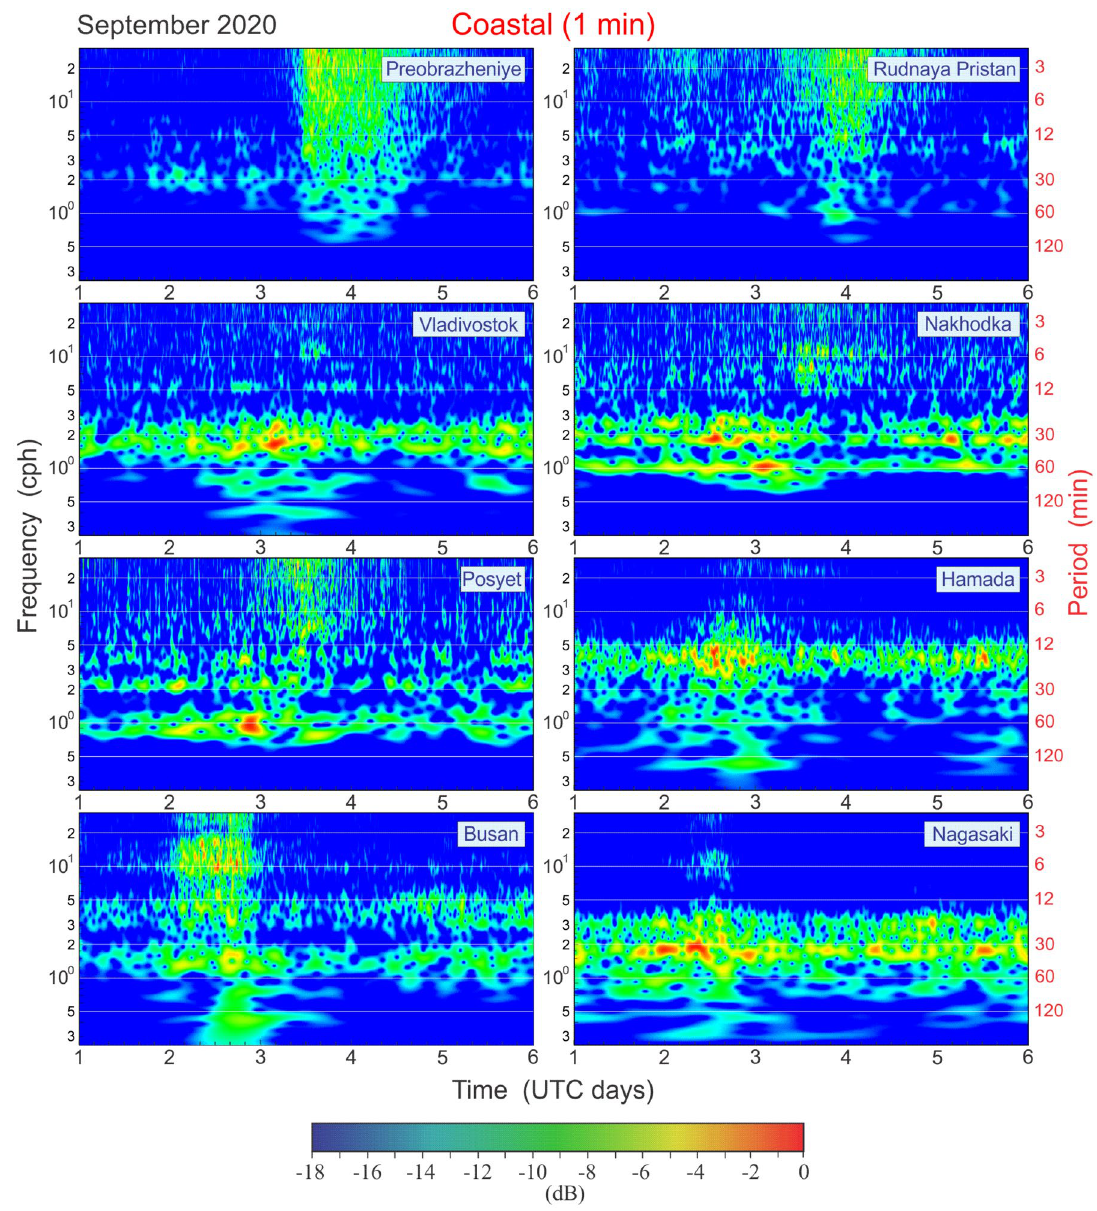
Figure 4. Frequency–time plots ( f–t diagrams) for the 1–6 September 2020 residual and high-pass filtered sea level records during the passage of Typhoon Maysak for eight tide gauges on the coasts of Japan, South Korea, and